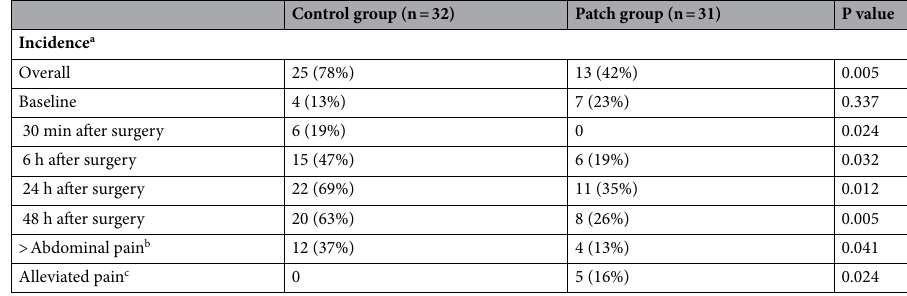
Table 2. Incidence of shoulder pain. Values are presented as number (proportion). a Incidence was defined as the number of patients having higher shoulder pain compared with baseline. b The number of patients having worse shoulder pain compared with abdominal pain. c The number of patients having less shoulder pain compared with baseline.